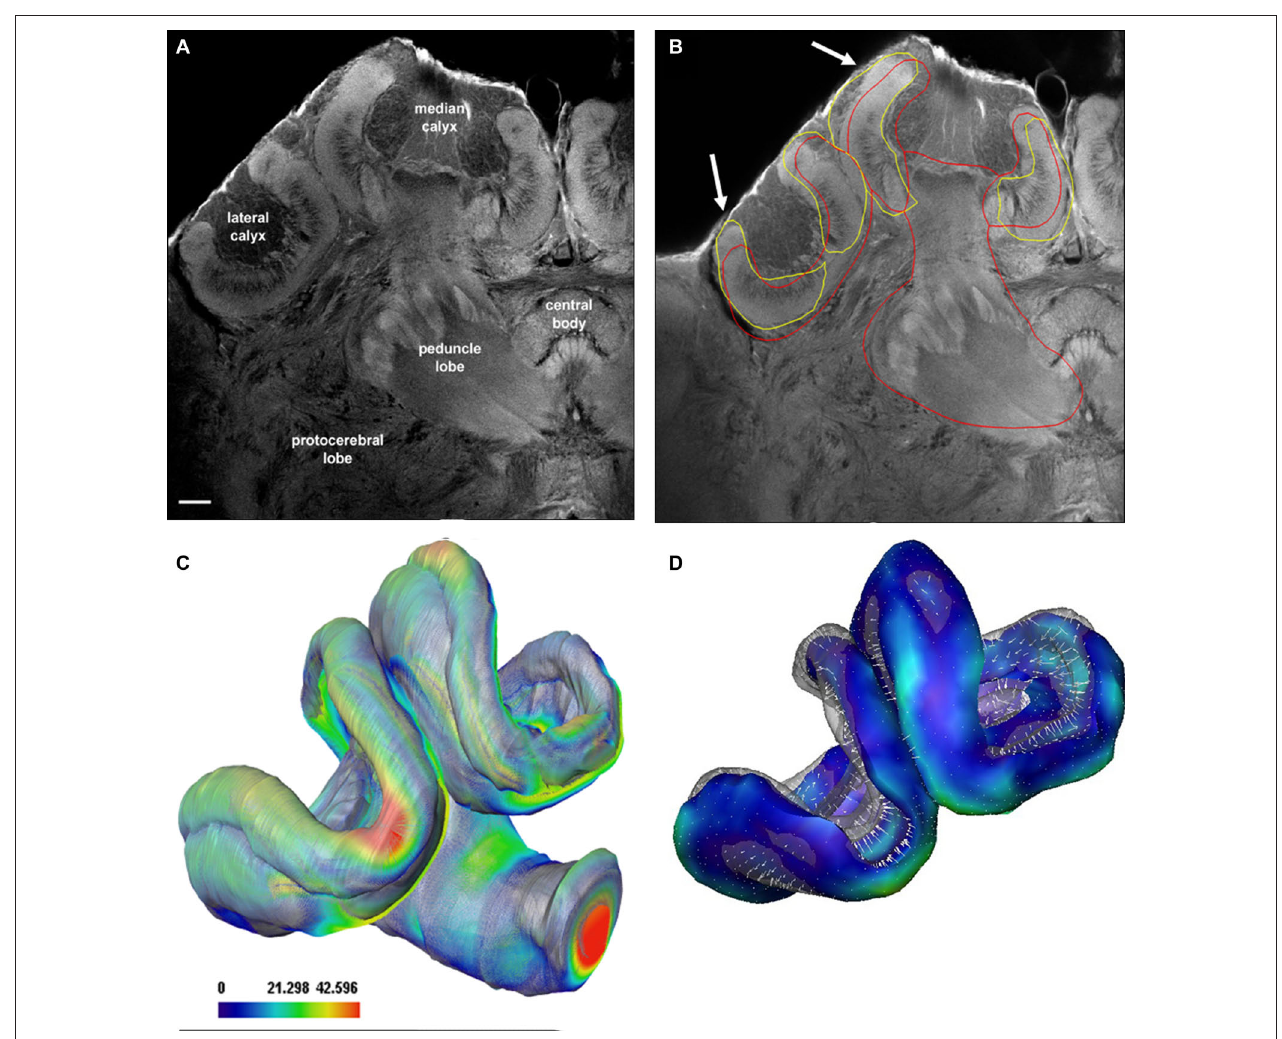
Figure 7 | evaluation of the auto-segmentation process using a reduced shape model for confocal imaging data. (A) Confocal Lucifer yellow image of the median and left brain hemisphere scanned with a 20 × oil objective. (B) Result of the automatic segmentation process. Arrows indicate refinement of automatic segmentation using isolated neuropils: yellow lines when only the calyx was used, red line when the whole mushroom bodies